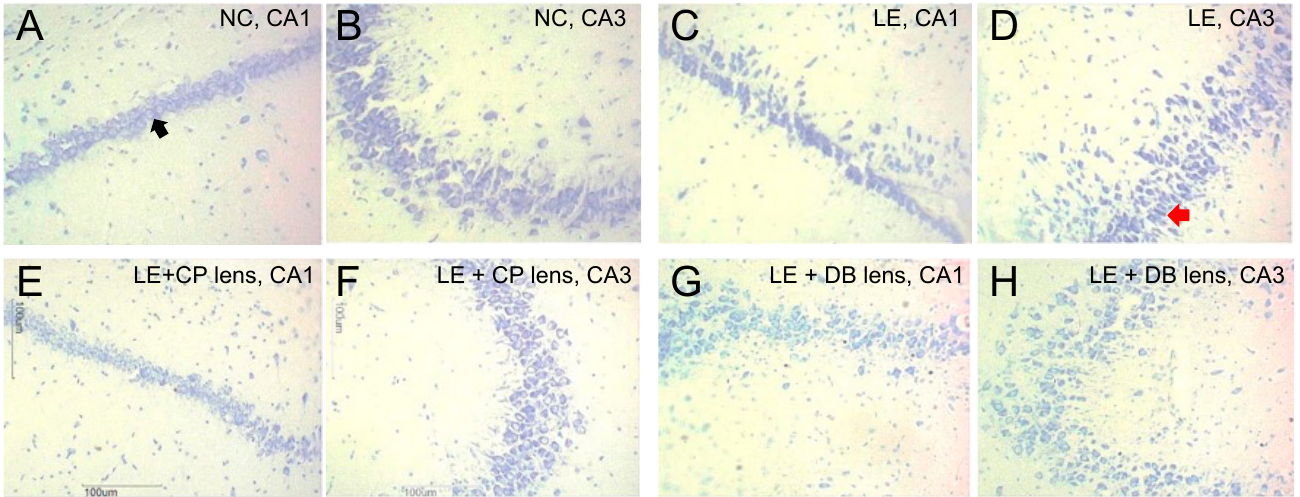
Figure 4. Representative micrograph of Cresyl-violet-stained CA1 and CA3 neurons. ( A ) Normal control CA1 region. Black arrow indicates a healthy neuron. ( B ) Normal control CA3 region. ( C ) light exposure (LE) CA1 region. ( D ) LE CA3 region. Red arrow indicates a degenerated neuron. ( E ) CP lens CA1 region. ( F ) CP lens CA3 region. ( G ) DB lens CA1 region. ( H ) DB lens CA3